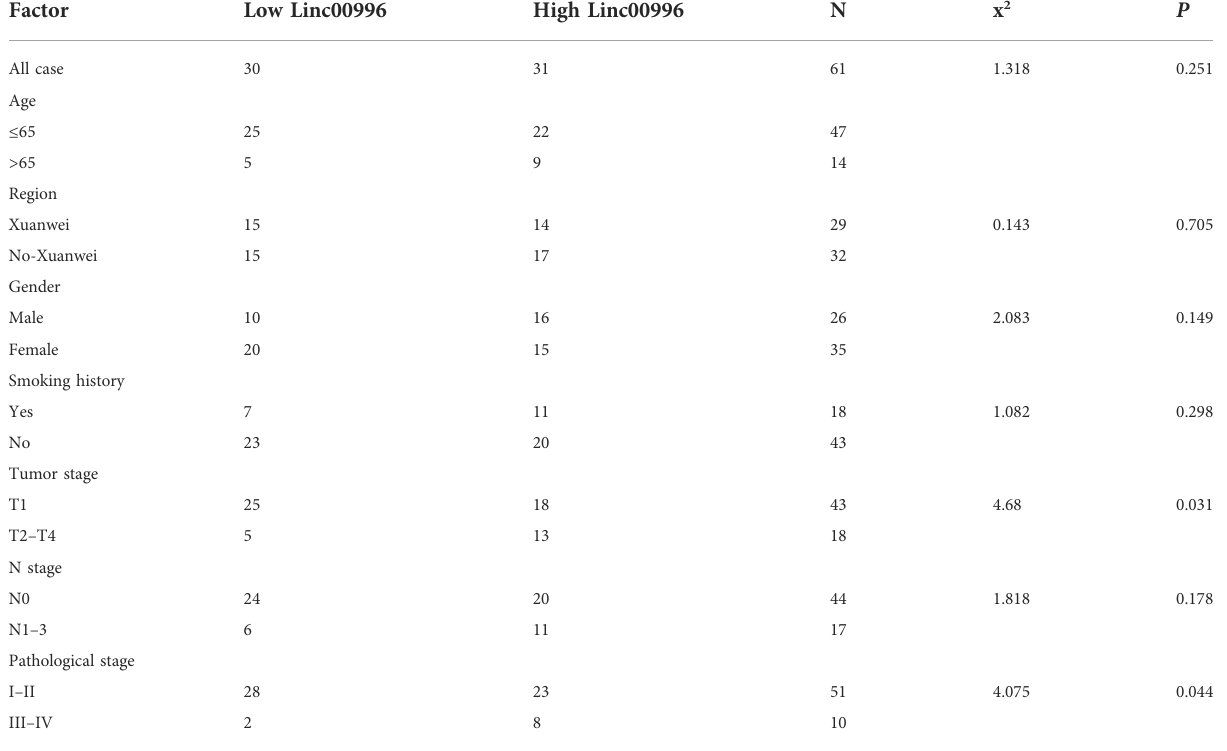
TABLE 2 Relationship between Linc00996 and the clinicopathological characteristics in 61 patients with LUAD.